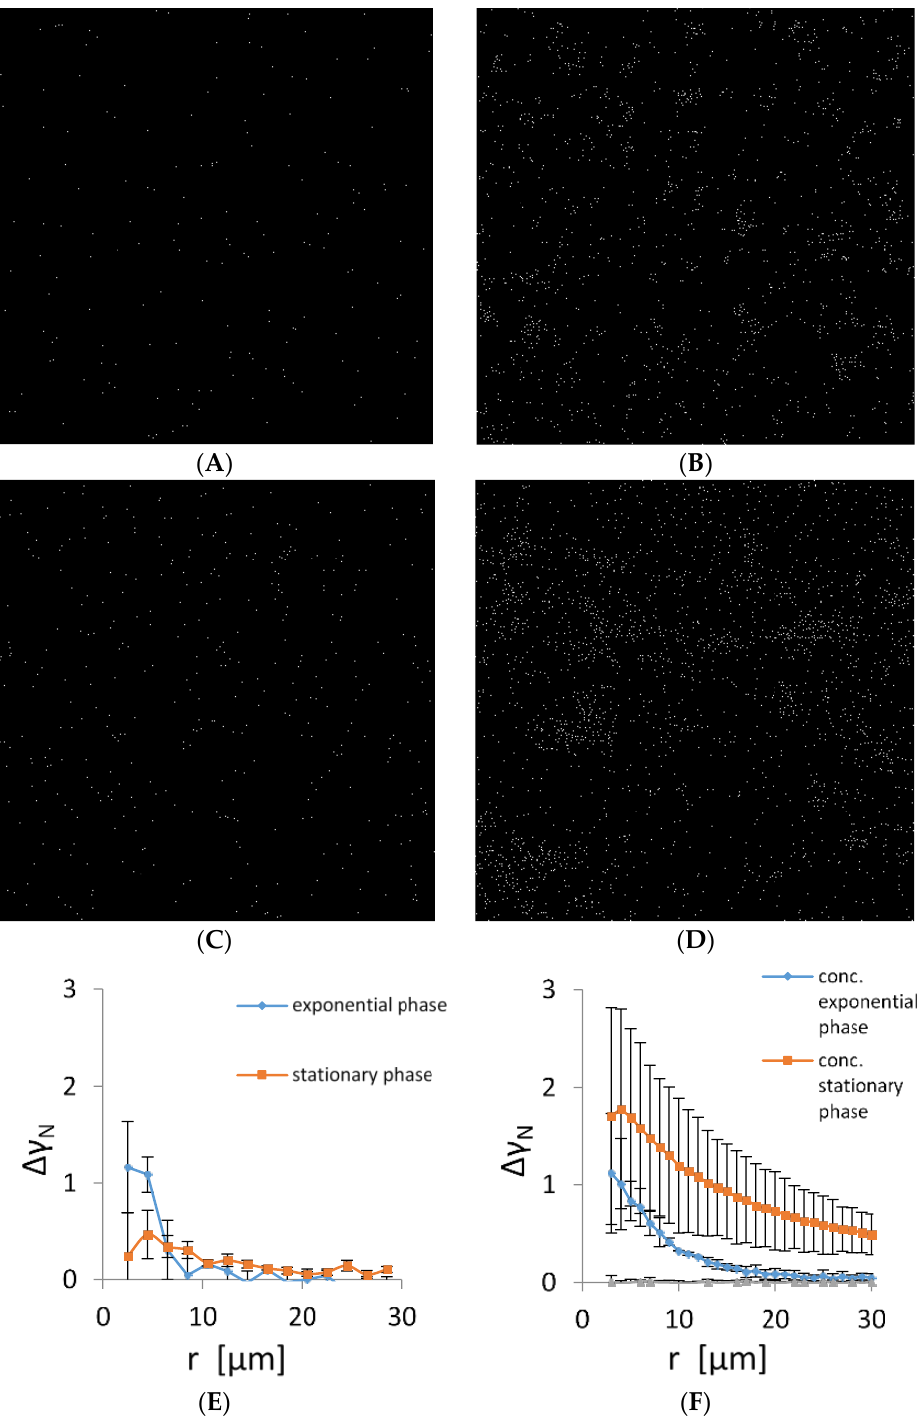
Figure 3. Positions of individual bacteria on microscopy images of size 400 µ m × 400 µ m grown in CM growth medium. ( A ) Cells in the early exponential growth phase, ( B ) early exponentially grown cells that were concentrated 5-fold, ( C ) cells in the early stationary growth phase, ( D ) the early stationary cells concentrated five folds. Scale bar corresponds to 20 µ m. ( E ) Pair-wise (autocorrelation) function (Equation (3)) applied to bacterial positions in microscopy images corresponding to an area of 20 times of the areas depicted in panels ( A – D ). ( F ) Autocorrelation of 5-fold concentrated bacterial suspension. For comparison, a pair-wise correlation function is given for computer generated random autocorrelation function (grey line).